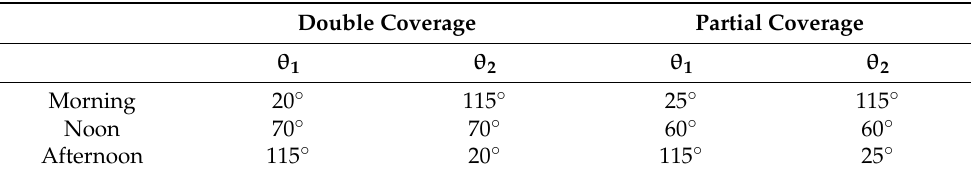
Figure 8. The irradiance falling on the system for the city of Jeddah for the cases of C1 (double coverage) and C2 (partial coverage) with three different operation schemes. For ( a ) the longest and ( b ) shortest days of daylight in the year. The calculated B PV values for a simple PV panel followed the same pattern, as B S but Table 2. The mirror inclination angles when fixed at three positions for double and partial coverage (for the city of